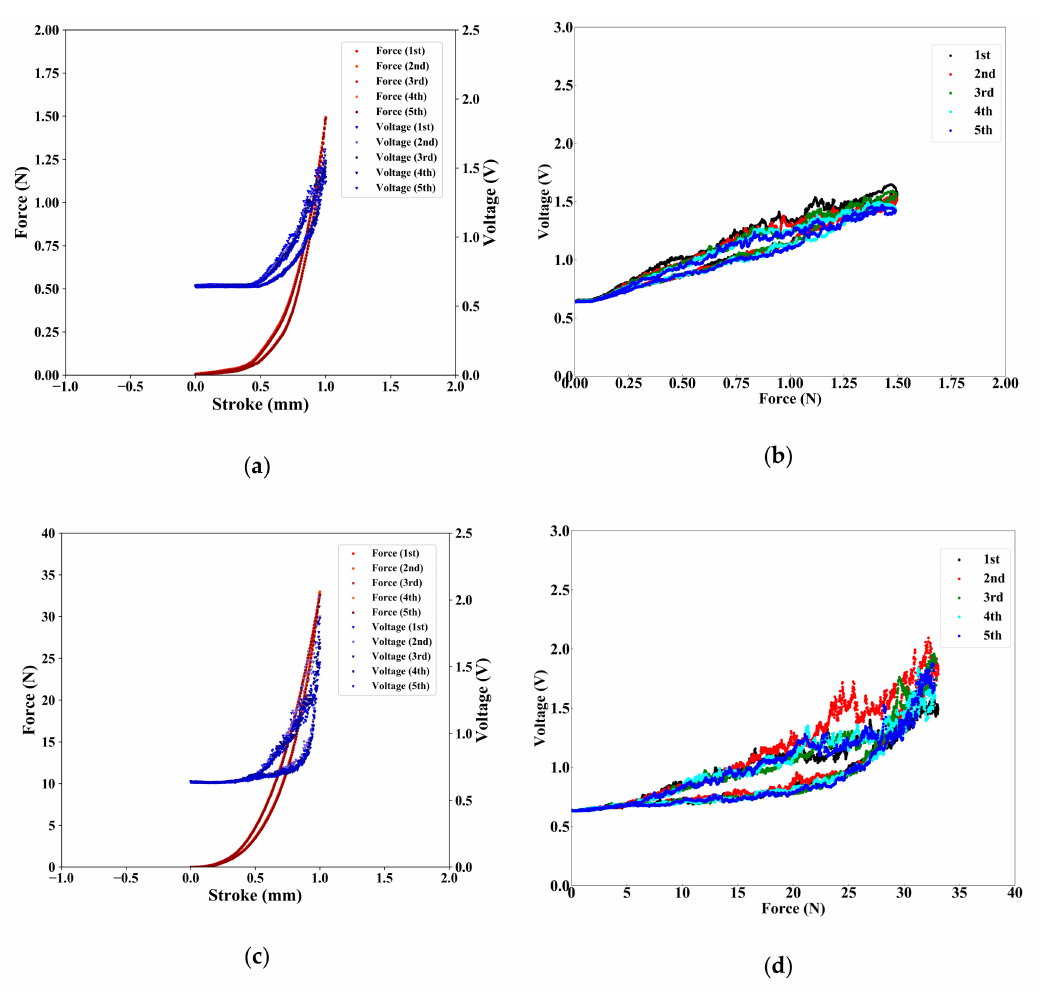
Figure 5. Results of evaluation of hysteresis. ( a ) Changes of force (from a reference value) and voltage in soft-MPS (soft) vs. stroke (1 mm / s). ( b ) Change of voltage in soft-MPS (soft) vs. force. ( c ) Changes of force and voltage in soft-MPS (hard) vs. stroke (1 mm / s). ( d ) Change of voltage in soft-MPS (hard) vs.